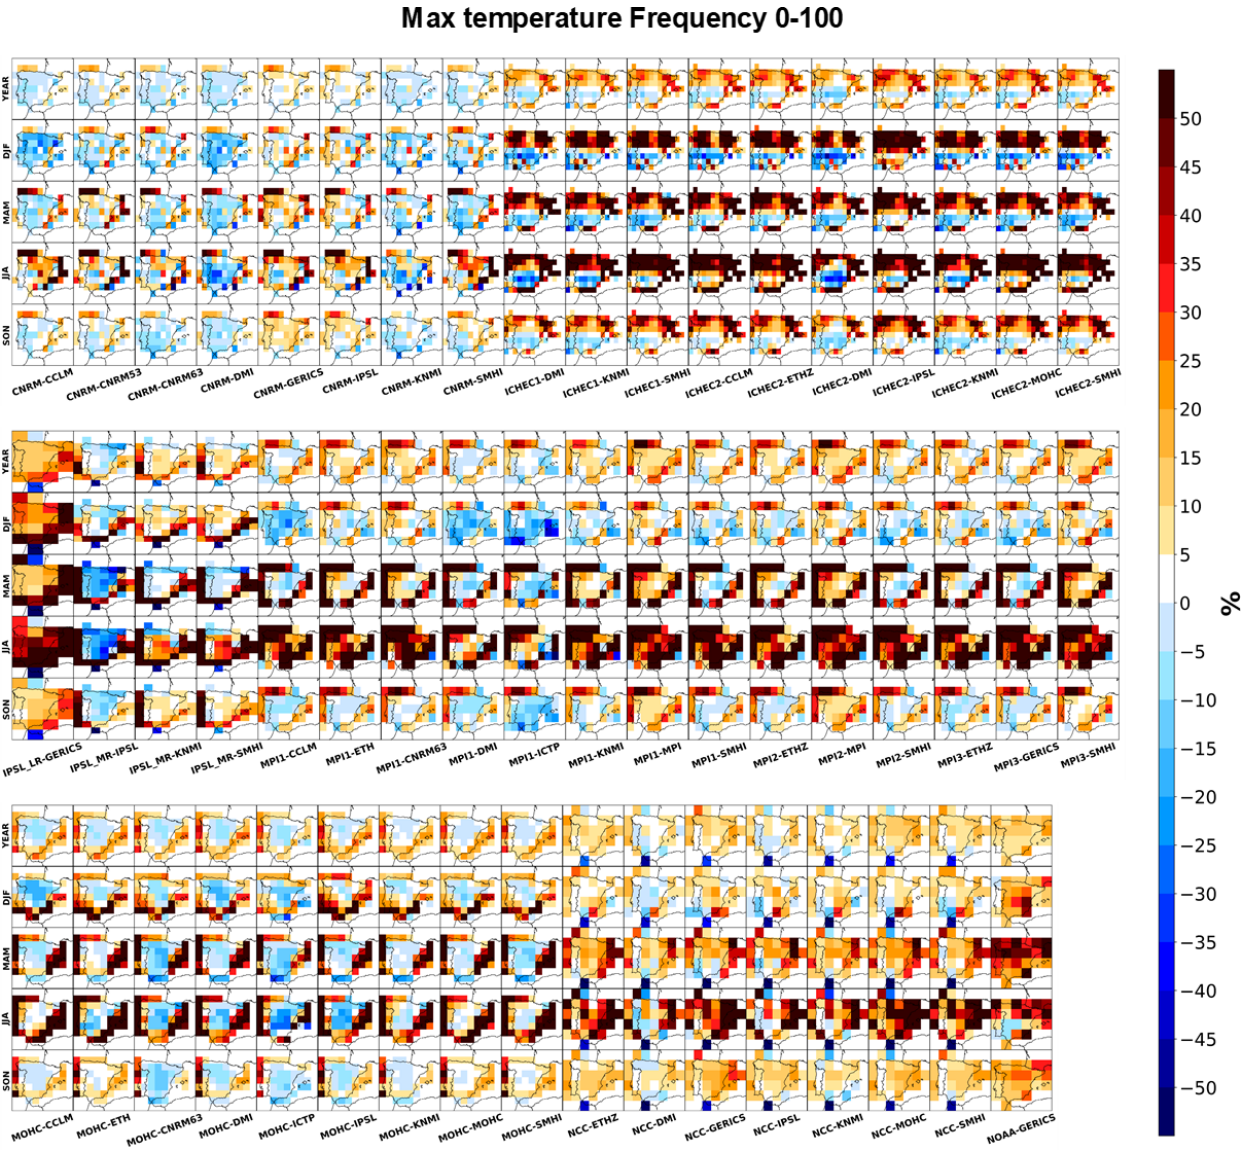
Figure 5. Yearly and seasonal distribution added values (DAVs) of the Iberian Peninsula for the historical (1971–2005) EURO-CORDEX RCMs, with the IGD as a reference for the maximum daily temperature, considering the whole PDF. All RCM data were previously interpo- lated to 0.1 ◦ regular resolution from the observations, while the observations were interpolated into each CMI5 GCM